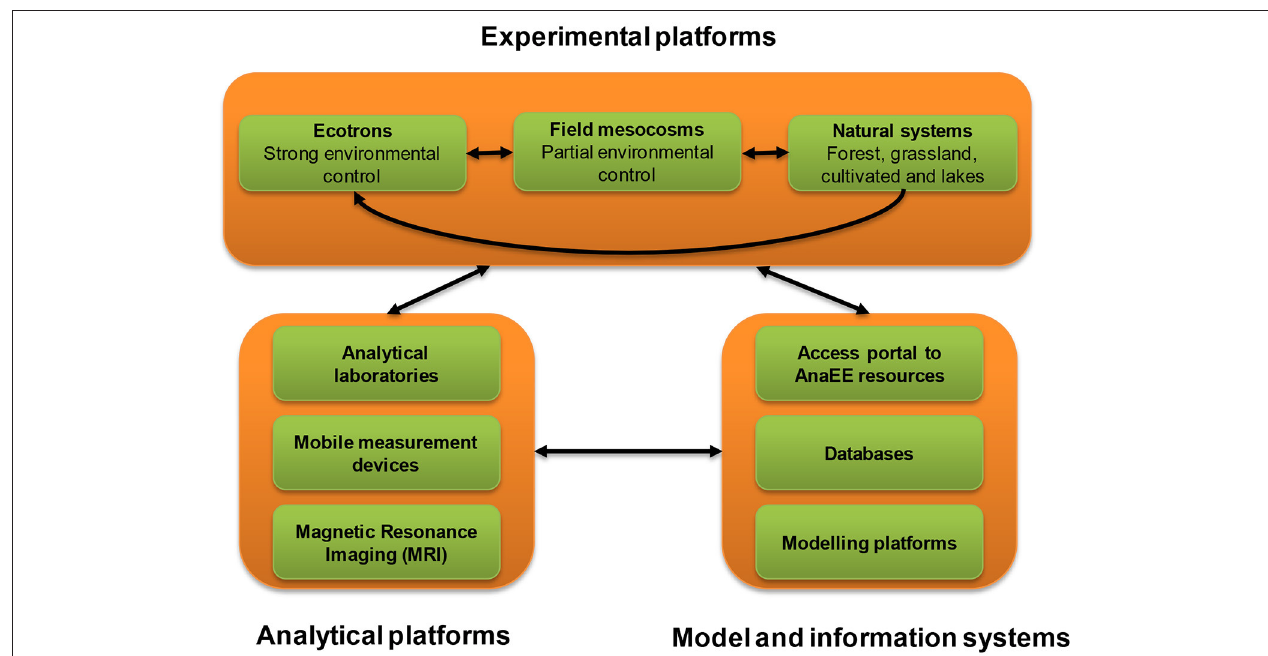
FIGURE 2 | General organization of the experimental facilities along a gradient of size of the experimental set-ups complemented by analytical facilities, modeling platforms and information systems. The degree of control of environmental conditions diminishes from Ecotrons to field experiments (see Figure 1 ).